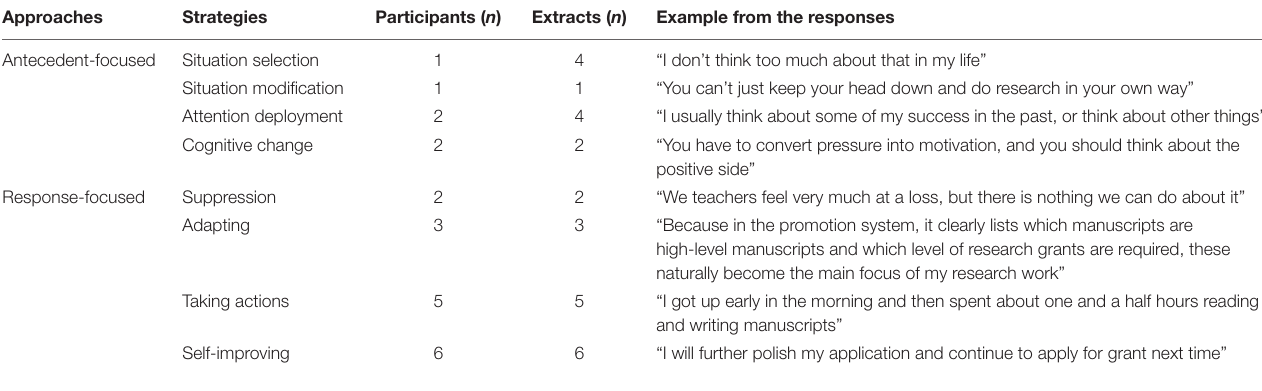
TABLE 4 | The participants’ emotion regulation approaches and